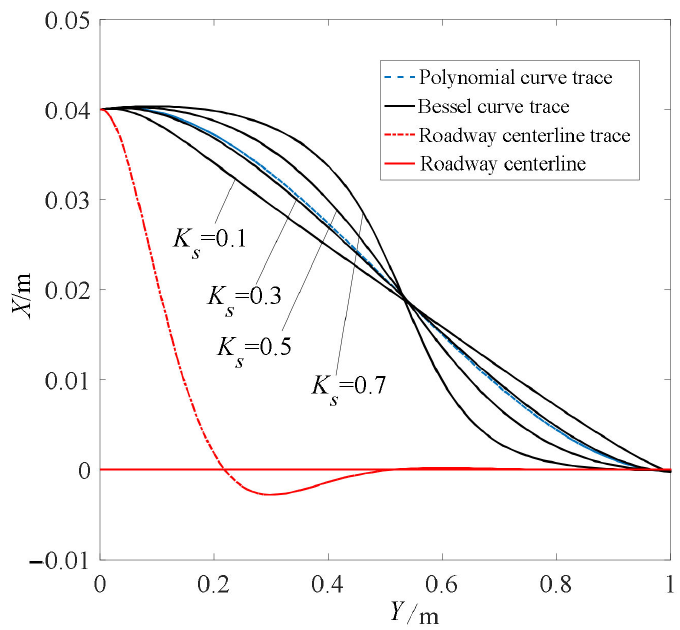
Figure 11. A comparison of the tracking trajectories of different planning